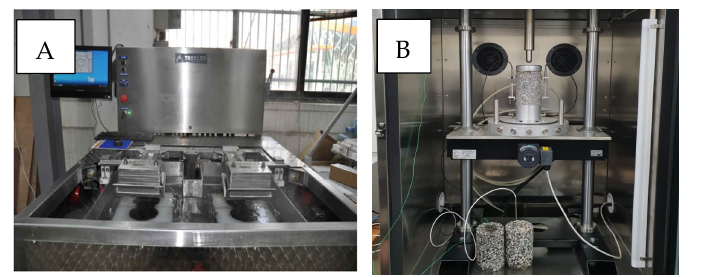
Figure 2. ( A ) Hamburg wheel tracking test and ( B ) dynamic modulus test.